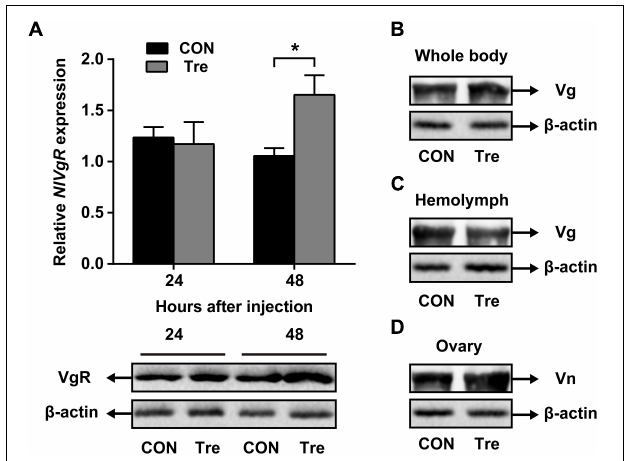
FIGURE 5 | Effects of trehalose injection on the Nl Vg biosynthesis and transportation after NlAKHR knockdown. Newly emerged females were injected with dsAKHR and reared for 2 days, at which point the females were injected with either trehalose (Tre) or ultrapure water (control, CON). (A) The ovary was dissected 24 and 48 h after trehalose injection. Differences between NlVgR mRNA levels were determined by qPCR and Nl VgR protein amounts were measured by western blot. Nl Vg protein levels in the whole body (B) and hemolymph (C) and Vn in the ovary (D) were determined 48 h after trehalose injection. Results are means ± SE from three independent experiments and asterisk represents significant difference at P < 0.05 by Student’s t -test.